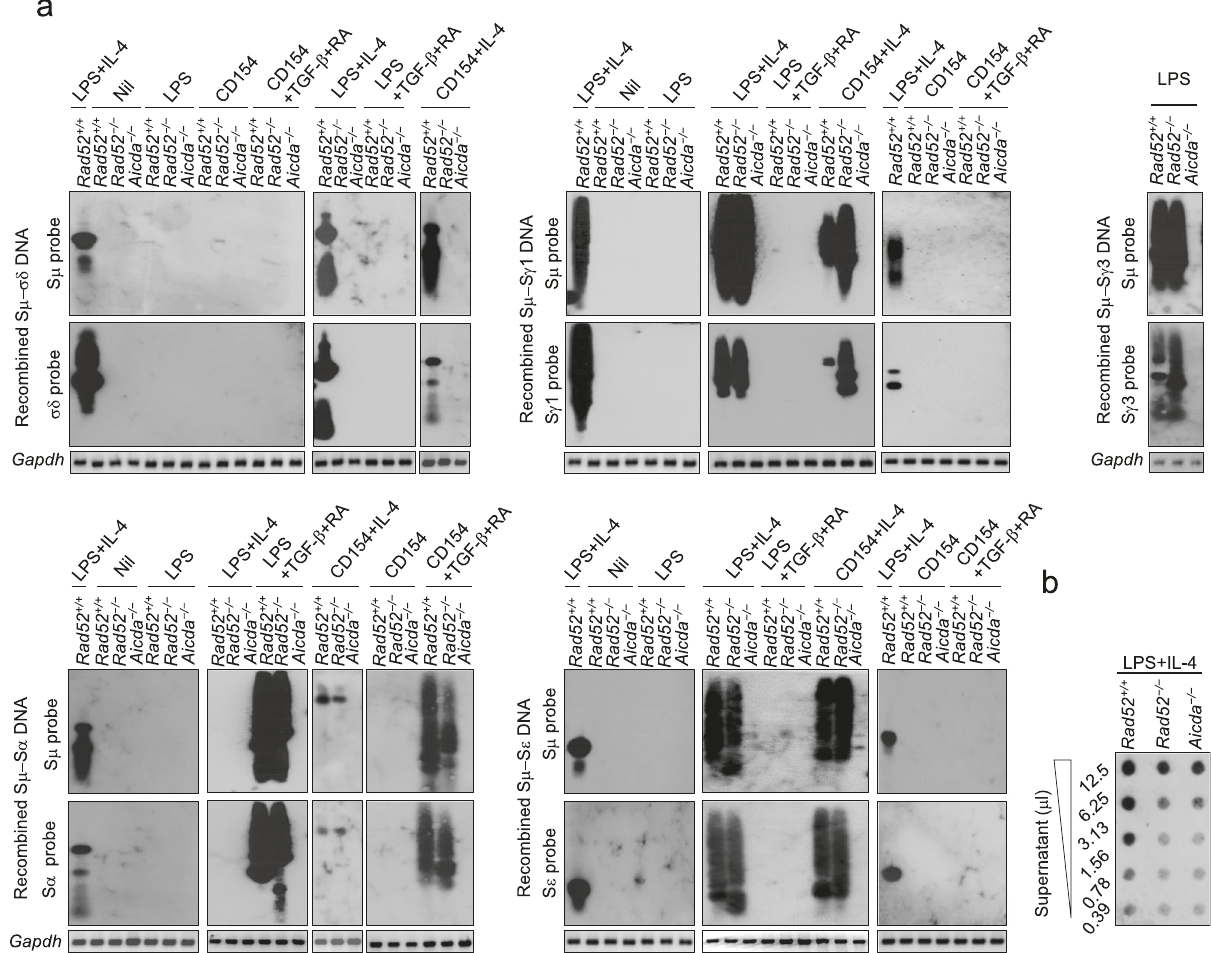
Fig. 4 Rad52 mediates S μ – σδ DNA recombination leading to IgD secretion. a Recombined S μ – σδ , S μ − S γ 1, S μ − S α , and S μ − S ε DNAs in mouse Rad52 + / + , Rad52 − / − and Aicda − / − naïve IgM + IgD + B cells stimulated with nil, LPS alone, LPS plus IL-4, LPS plus TGF- β and RA, CD154 alone, CD154 plus IL-4, or CD154 plus TGF- β and RA, as well as S μ – S γ 3 in Rad52 + / + , Rad52 − / − and Aicda − / − B cells stimulated with LPS only, were analyzed 96 h post-stimulation by speci fi c nested PCR using forward I μ and reverse C δ , S γ 1, S γ 3, S α , or S ε primers, respectively, followed by Southern-blotting using speci fi c S μ , σδ , S γ 1, S γ 3, S α , or S ε probe, as indicated. Data are one representative of three independent experiments yielding comparable results. b IgD titers in culture (96 h) fl uid of Rad52 + / + , Rad52 − / − or Aicda − / − B cells stimulated with LPS plus IL-4, as measured by dot-blotting (two-fold serial diluted culture fl uid) using a rat anti-mouse IgD mAb. Data are one representative of fi ve independent experiments yielding comparable results. Source data are provided as a Source Data fi